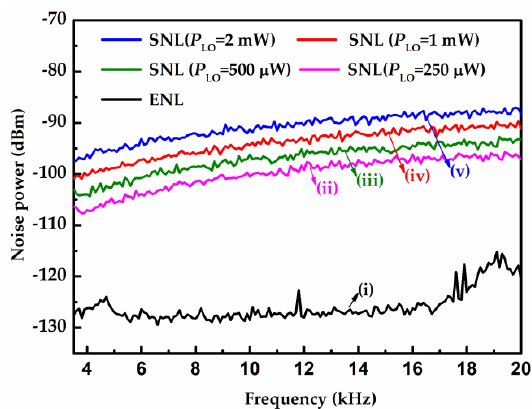
Figure 5. Measured noise power from unbalanced detector and balanced detectors as a function of analysis frequencies: Curve (i), detector unbalanced; and Curve (ii), detectors balanced. The CMRR of photodetectors in the BHD system was determined by the difference of noise power from balanced detectors and that from unbalanced detector. The inset is the measurement for the CMRR of photodetectors at the analysis frequency of 5 kHz.